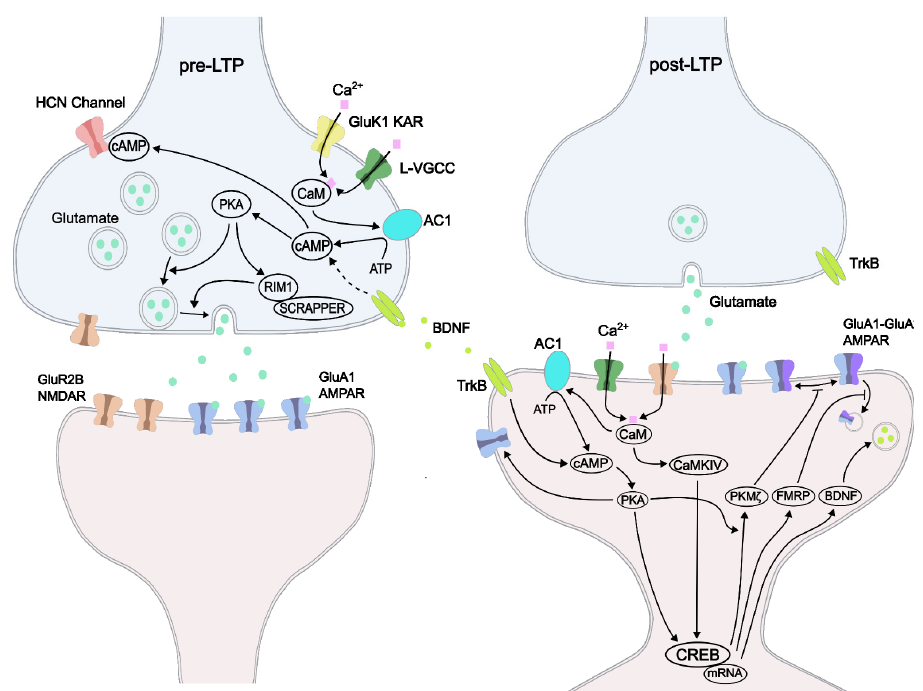
Figure 3. ACC pre-LTP and post-LTP. Two forms of LTP (pre and post) can be observed in the ACC. Presynaptic enhancement of vesicle formation, pool size, and neurotransmitter release probability lead to more readily available agonists of ionotropic glutamate receptors in the synaptic cleft. This can quickly saturate postsynaptic receptors leading to increased calcium influx through the postsynaptic membrane. GluK1-containing kainate receptors (KARs) and ligand-voltage-gated calcium channels (L-VGCCs) allow for the influx of Ca 2+ , which activates calmodulin (CaM). Activation of adenylyl cyclase 1 (AC1) by CaM leads to cAMP and protein kinase A (PKA), which enhances vesicle fusion. Regulating synaptic membrane exocytosis protein 1 (RIM1) together with SCRAPPER, a synapse- localized E3 ubiquitin ligase can upregulate synaptic vesicle release. In addition, activity of the HCN channel with cAMP is believed to modulate the spontaneous release of neurotransmitters. Post-LTP requires the activation of postsynaptic NMDARs, which through the influx of Ca 2+ can activate the CaMKIV, which activates the cAMP response element-binding protein (CREB). Once activated by cAMP, PKA upregulates the insertion of Ca 2+ permeable AMPARs to the membrane surface and phosphorylates CREB leading to increased protein synthesis of PKM ζ , fragile x mental retardation protein (FMRP), and brain-derived neurotrophic factor (BDNF). BDNF interacts with presynaptic and postsynaptic TrkB receptors and contributes to LTP via the AC1-PKA pathway. De novo synthesis of proteins contributes to increased survival, synaptic plasticity, and neuronal growth, which can persist over a long period of time. As with the importance of PKA, activation of AC1 is also critical for the maintenance of